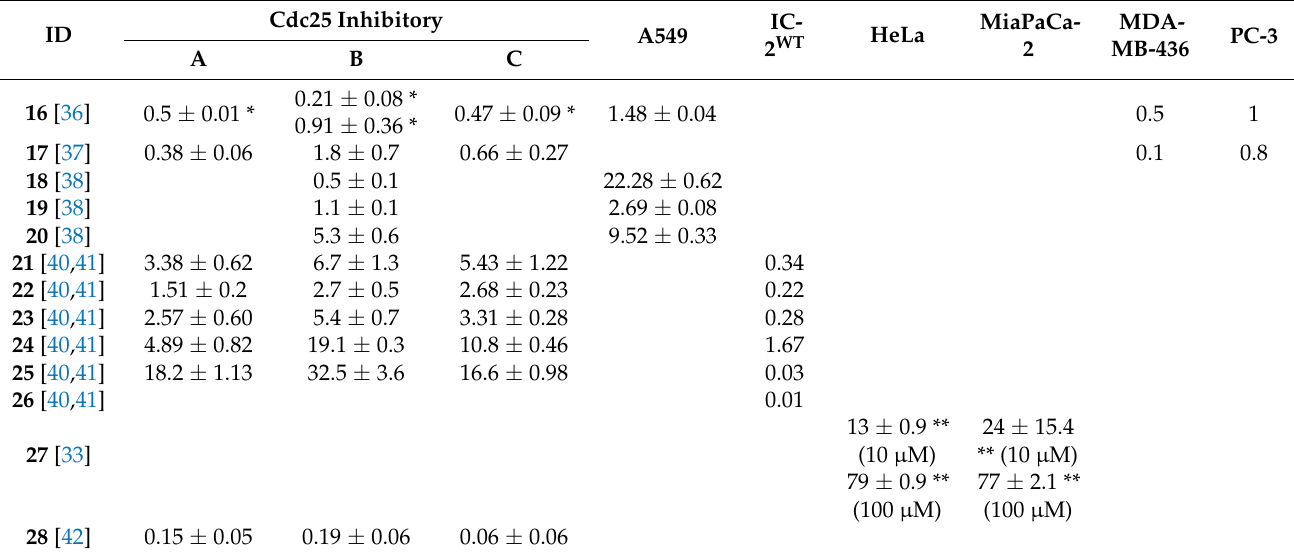
Table 2. Cdc25 inhibitors based on quinoid structure analogs of vitamin K3 substituted with het- eroatoms in the benzene ring.